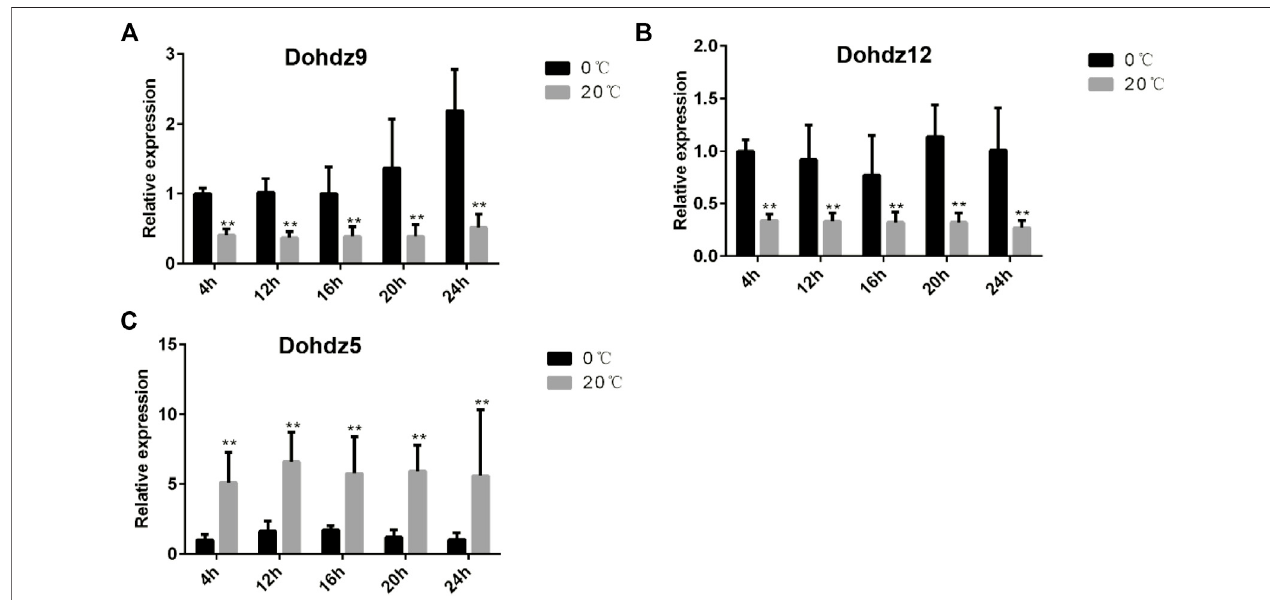
FIGURE 6 | Expression patterns of three cold-responsive HD-ZIP genes under cold stress and normal conditions through qRT-PCR analysis. (A – C) expression patterns of Dohdz9, Dohdz12, and Dohdz5, respectively. **, p < 0.01 (Student ’ s t-test). Gene expression pro fi les were evaluated using the 2 − ΔΔ CT